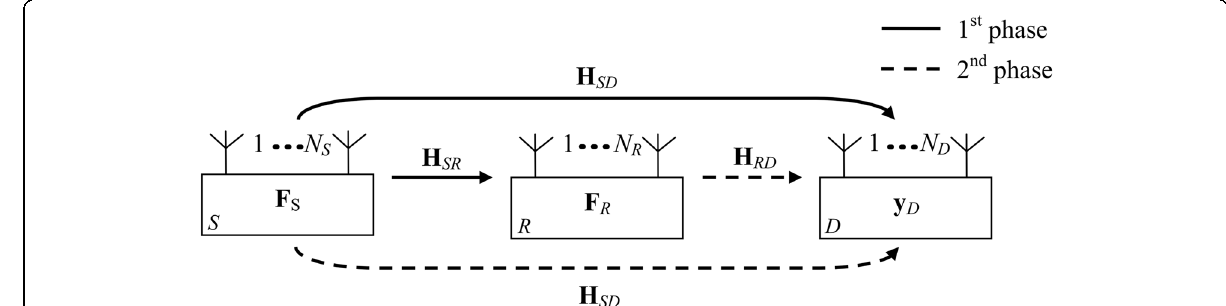
Fig. 1 Half-duplex non-orthogonal MIMO relaying